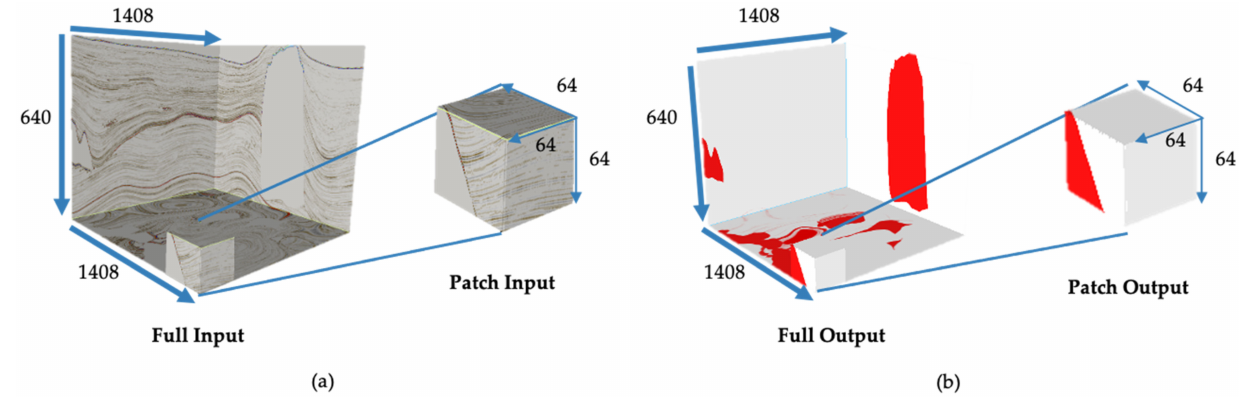
Figure 6. Process of creating small patches from ( a ) original seismic input volume with 1408 × 1408 × 640 size and ( b ) ground truth output volume with 64 × 64 × 64